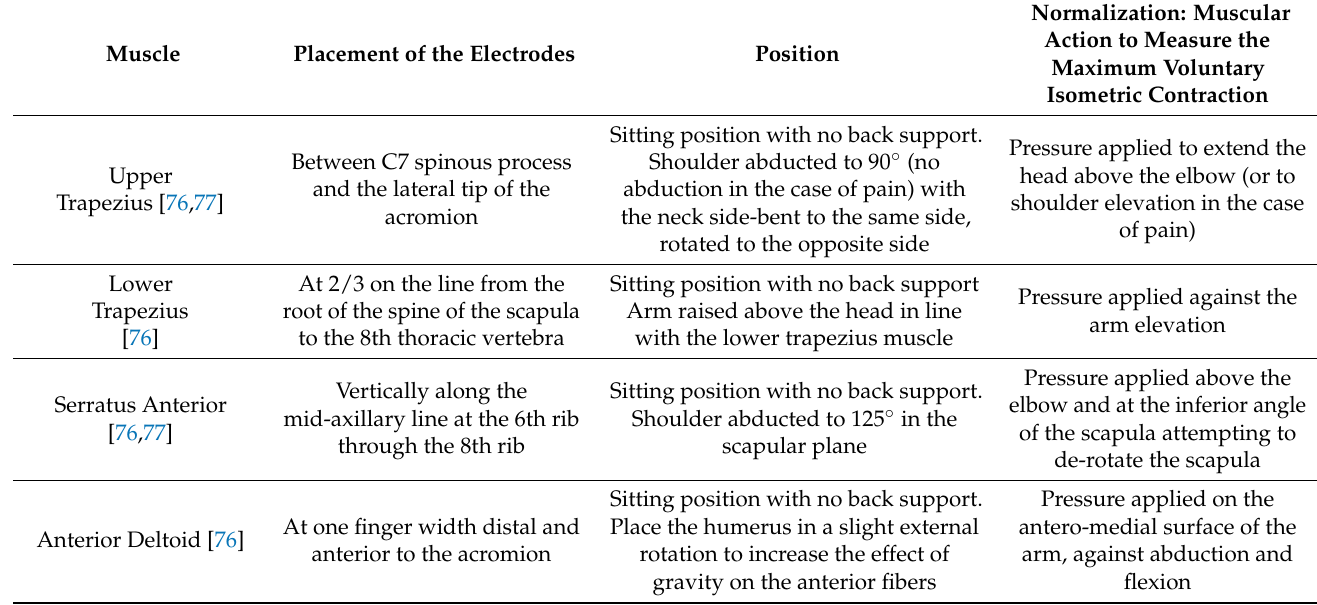
Table A1. Placement of the electrodes and normalization of EMG